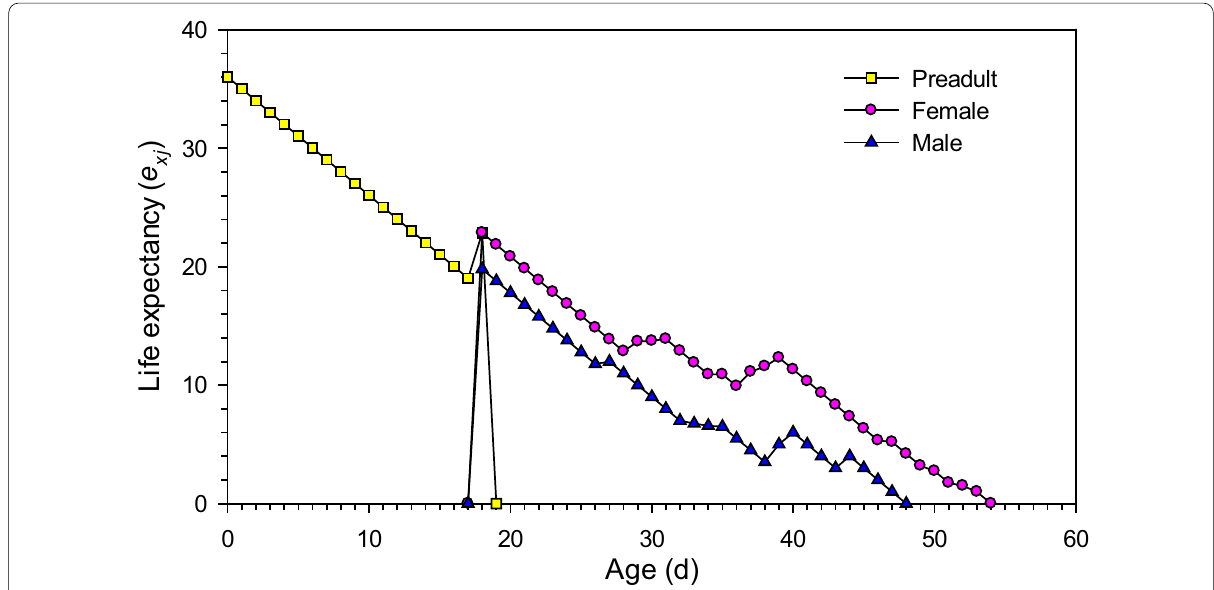
Fig. 3 Age-stage-specific life expectancy ( e xj ) of Leptomastix dactylopii on Planococcus